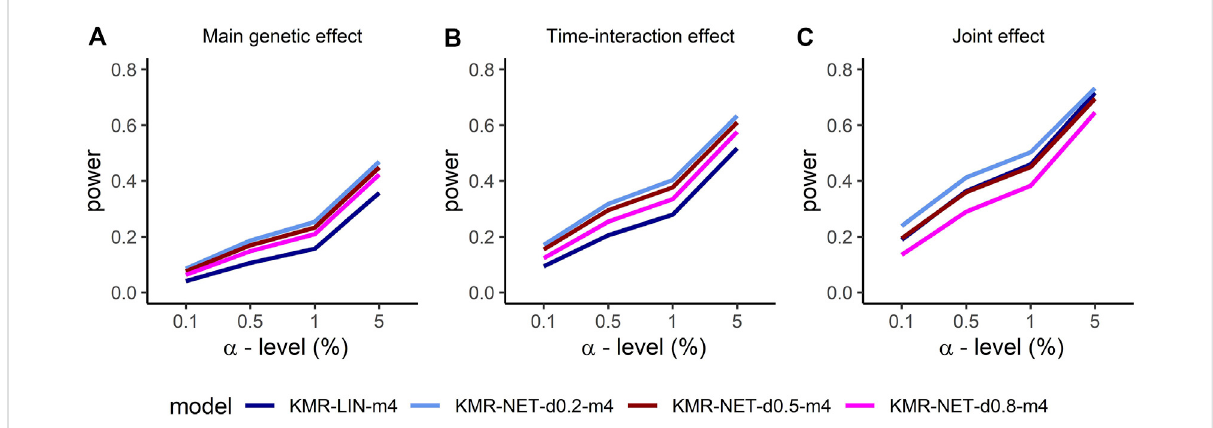
FIGURE 3 Comparison of the power for the four-measurement models (KMR-LIN, KMR-NET-d0.2, KMR-NET-d0.5, KMR-NET-d0.8) with complete phenotype data and effect size β = 0.04 for the different genetic effect models with (A) the main genetic (B) the time-interaction and (C) the joint effect in our simulation